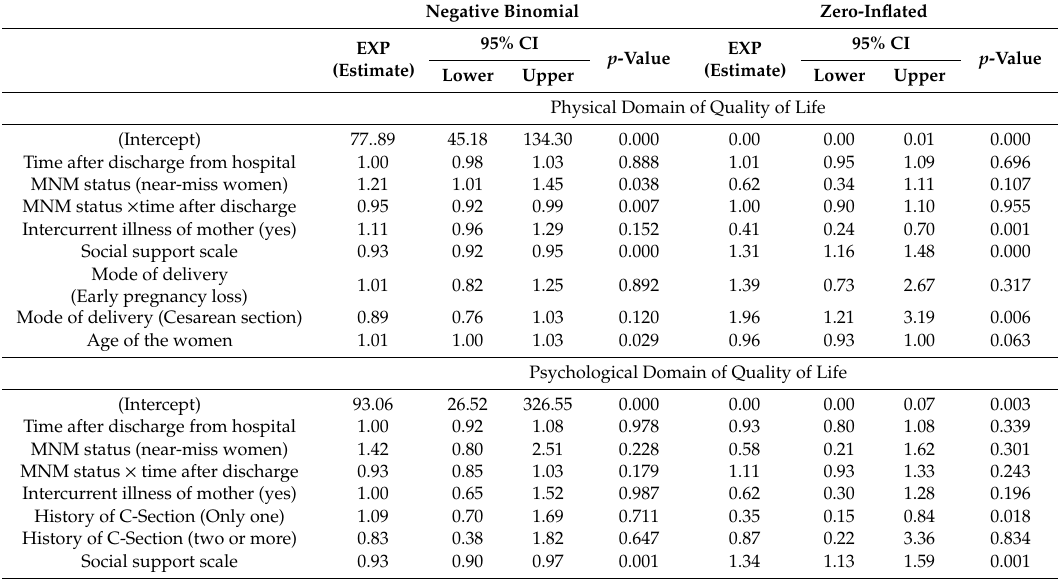
Table 4. Results of the negative binomial mixed-e ff ects model for four domains of quality of life a,b,c,d.